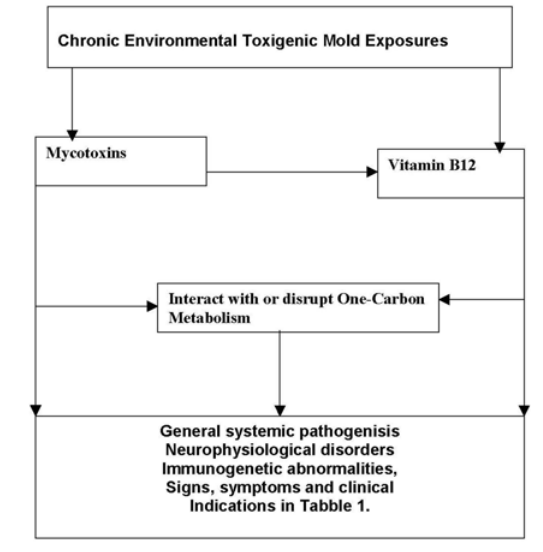
FIGURE 1: A proposed outline of the mechanism by which mycotoxins disrupt or interfere with the normal functional effects of vitamin B12 on one-carbon metabolism. It is likely that the interruption of the structure and function of vitamin B12 would in turn interfere with the one-carbon metabolism leading to the neurological